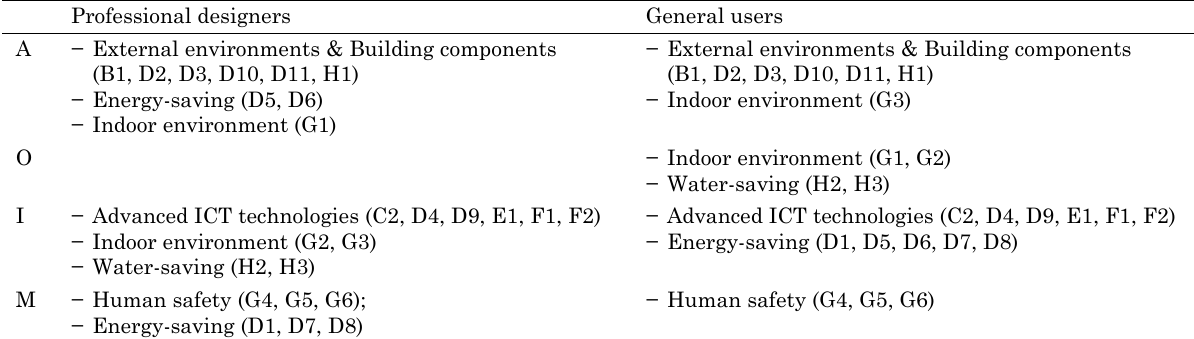
Table 5. Similarities and differences of respondents’ opinions Professional designers